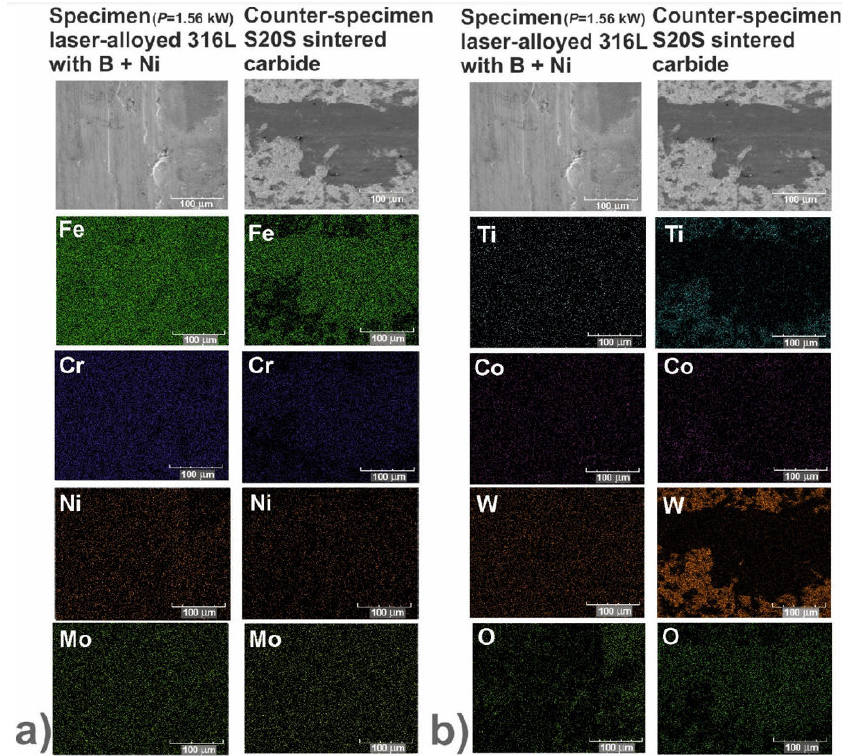
Figure 12. Worn surfaces of laser-alloyed specimen with boron and nickel using a dilution ratio of 0.48 ( P = 1.56 kW) and counter-specimen (S20S sintered carbide). ( a ) EDS patterns of the elements characteristic of the specimen as well as ( b ) the counter-specimen, taking into account oxygen concentration. Two-hour wear test with the change of counter-specimen at every 0.5